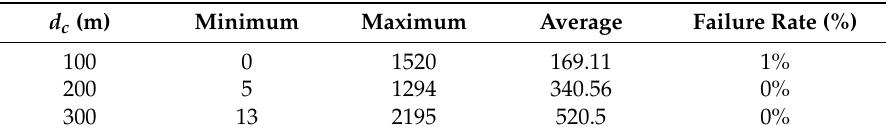
Table 3. Number of service result sets.